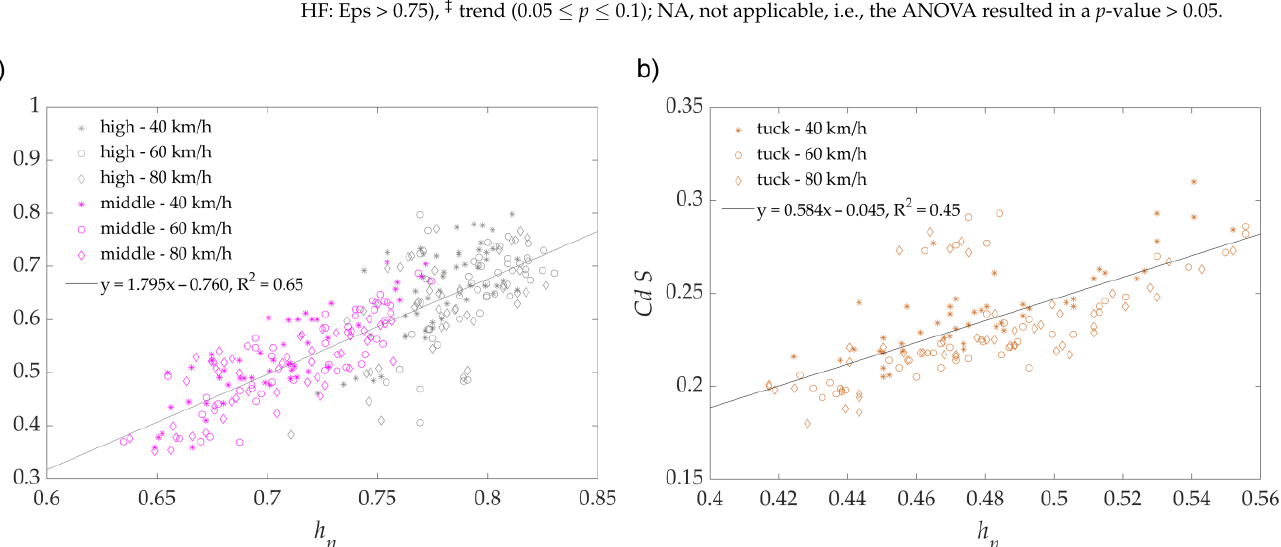
Figure 3. Linear regression model with R 2 values for the coefficient of the aerodynamic drag (C d ) and normalized cross- sectional area (S n ) as a function of normalized shoulder height (h n ): ( a , c ) in the high (violet) and middle positions (grey)), ( b , d ) in the downhill (tuck) position (brown). Figure 4 depicts the deviations between the actual measurements of parameters and the values calculated utilizing these regression models in the form of Bland – Altman plots